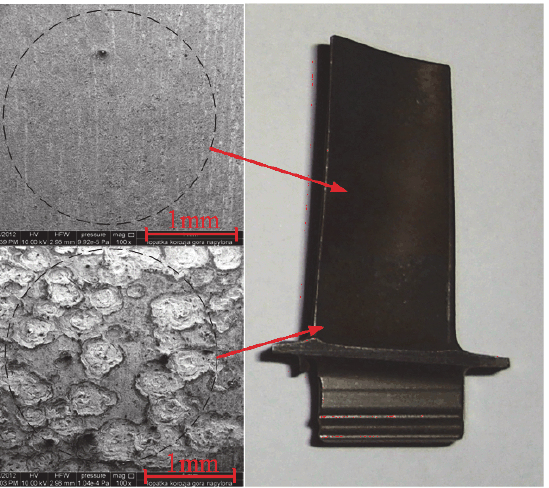
Figure 1: Surface of the blade. Figure 2: Maximum of the von Misess